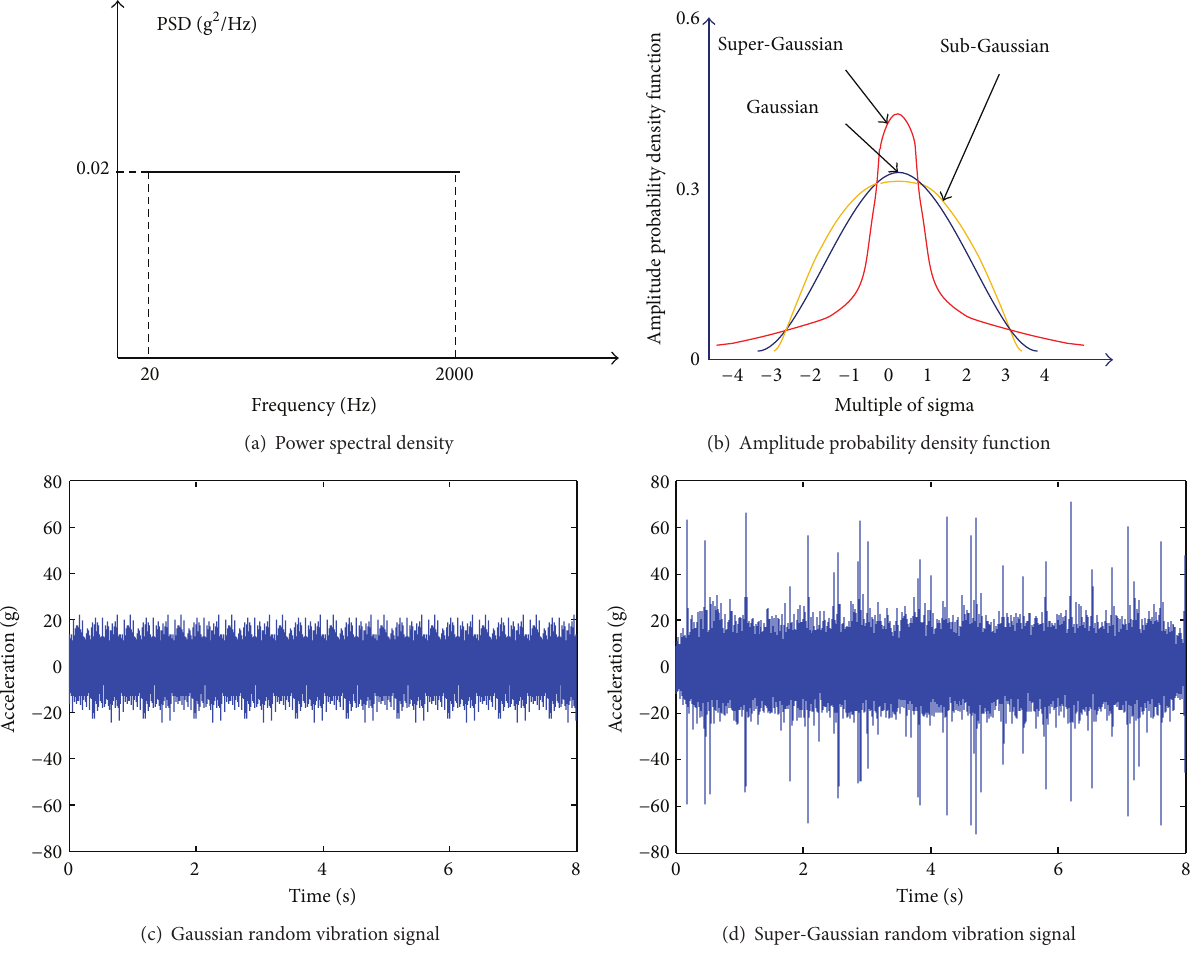
Figure 5: Gaussian and super-Gaussian vibration signals with the same